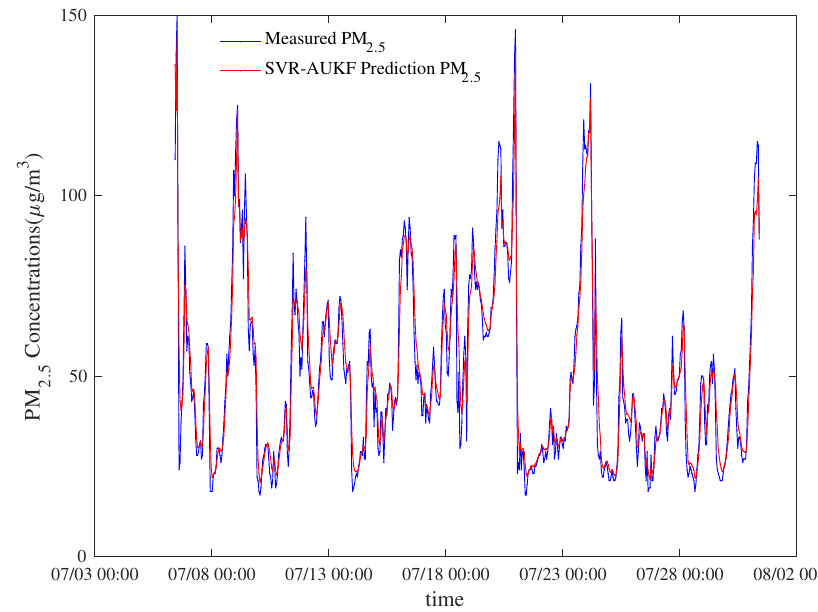
Figure 4. The PM 2.5 concentration prediction of single SVR-AUKF